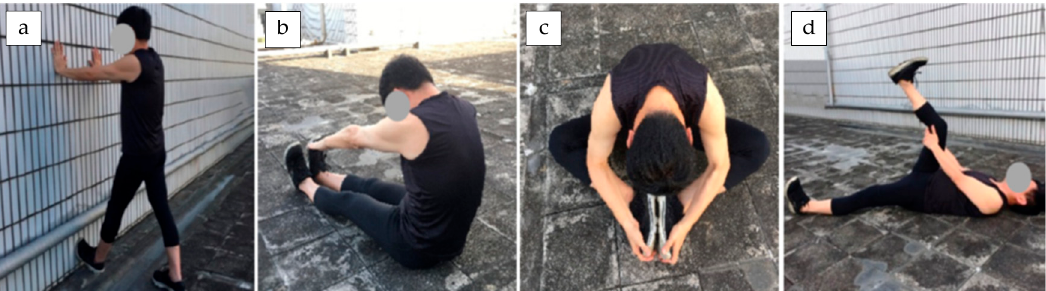
Figure 1. Four stretching protocols ( a – d ) after volleyball training used in this study. During stretching, each of the 4 protocols were performed over 1 min and repeated until the participants were instructed to stop stretching. Stretching frequency was con- trolled using a digital metronome for a total bout of stretching of 15 s (stretching followed by resting, 7.5 s of each) for trunk flexion, hamstring extension, or leg/foot lifting. The 4 stretching bouts were performed by participants over 1 min and repeated.